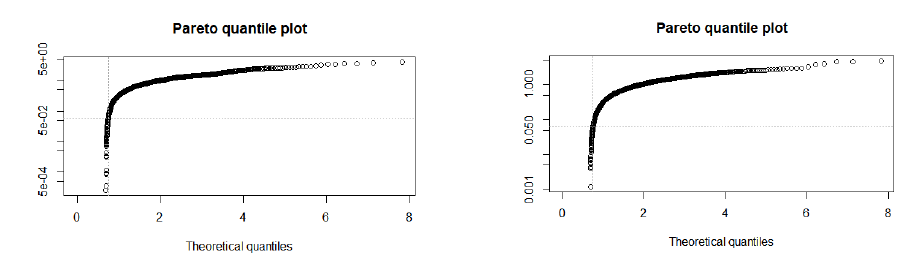
Figure 6. FTSE/JSE Banks Index Returns Pareto quantile plot of positive (left) and negative (right) standardized